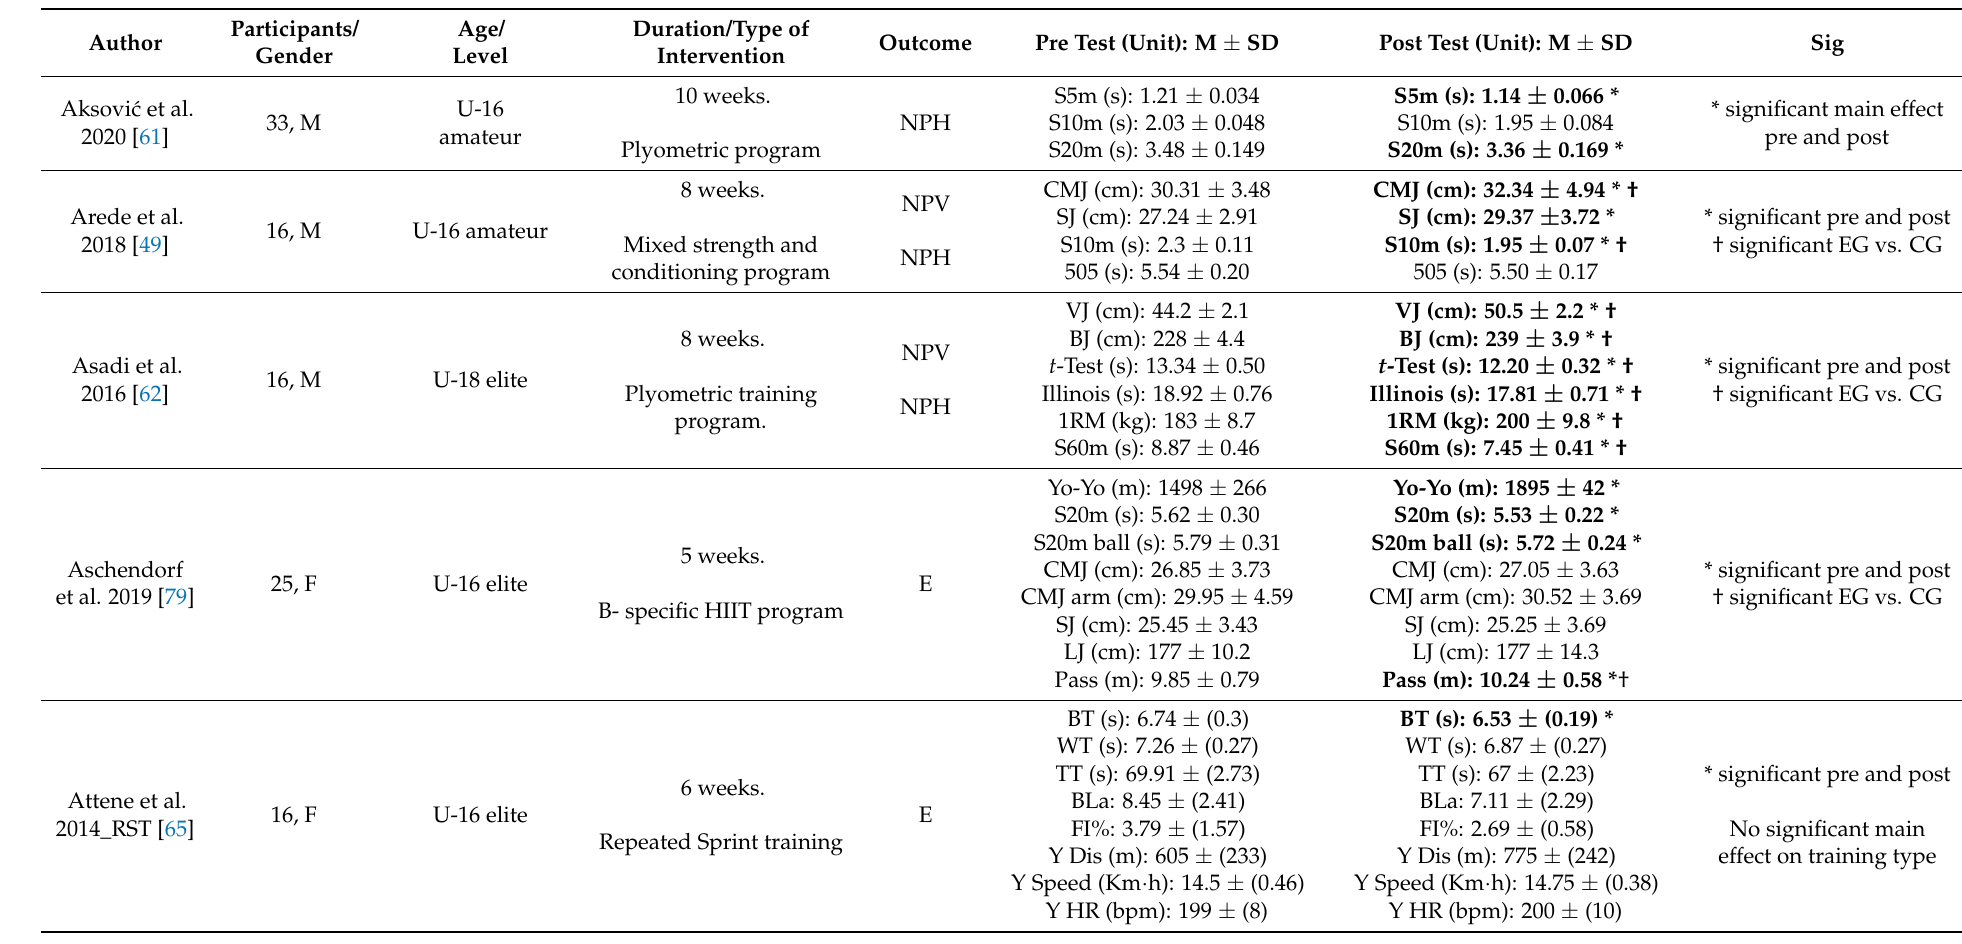
Table 2. Summary of the studies included in the meta-analysis. Bold numbers indicate significant changes between pre and